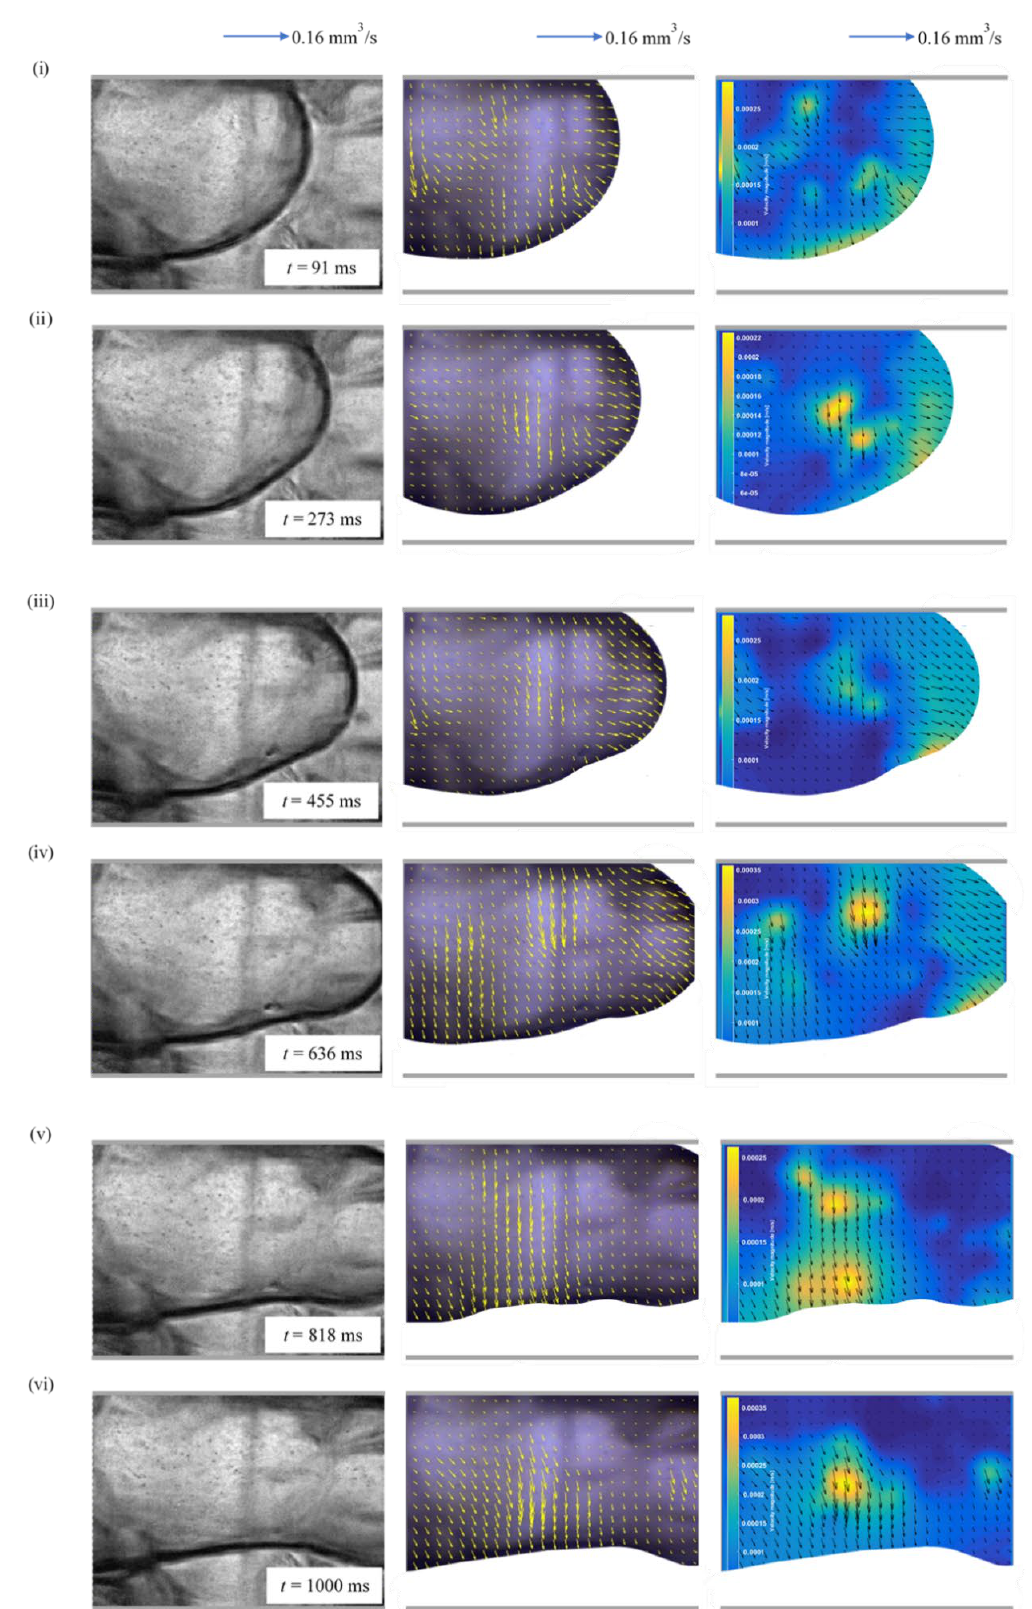
Figure 6. Pre-processing image, vector and velocity magnitude for the offset T-junction microchannel with a radius of 500 µm at ( i ) 91 ms, ( ii ) 273 ms, ( iii ) 455 ms, ( iv ) 636 ms, ( v ) 818 ms and ( vi ) 1000 ms.